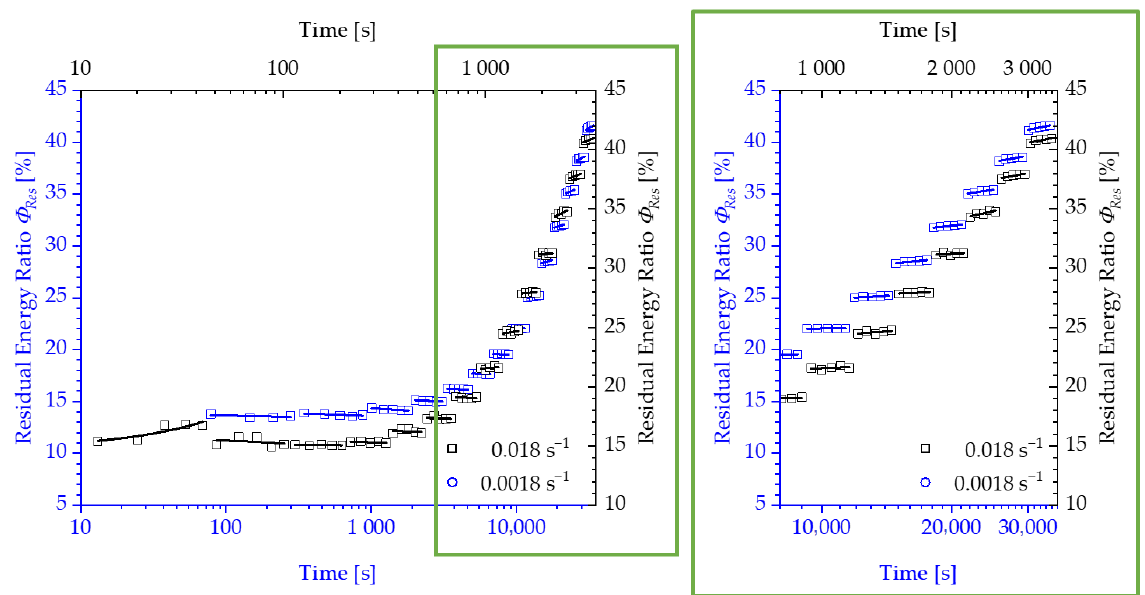
Figure 8. Development of the residual energy ratio φ Res for Neukadur ® for a test speed of 10 mm/s and 100 mm/s.